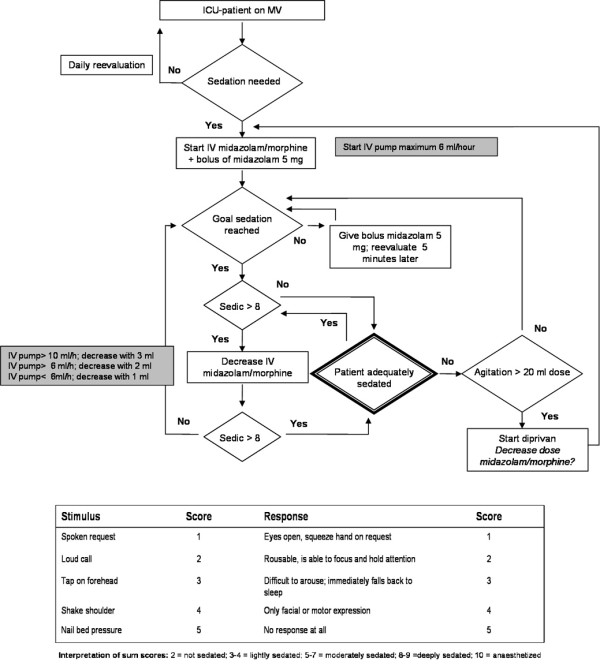
Diagram of the sedation protocol and Sedation Intensive Care (SEDIC) score. IV, intravenous; MV, mechanical ventilation.